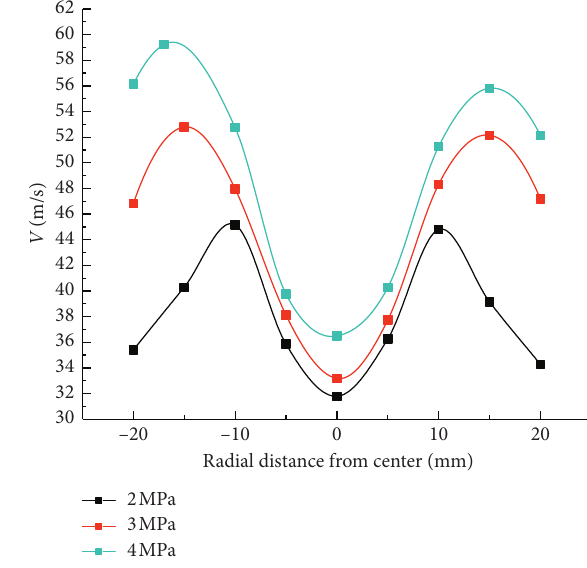
Figure 11: Test section.